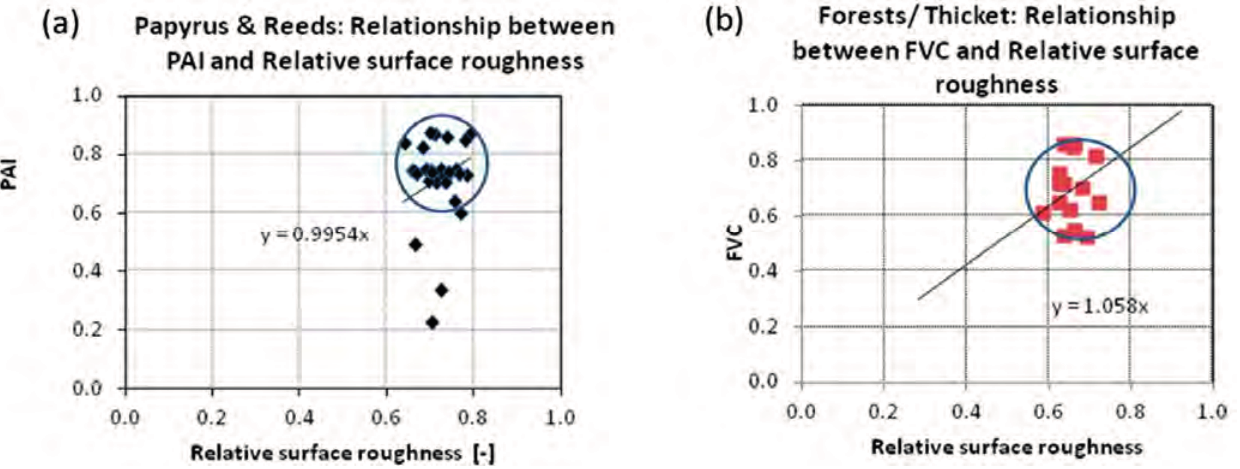
Figure 11. Correlation between Plant Area Index (PAI) and Fractional Vegetation Cover (FVC) against relative surface roughness. The correlation coefficient for plots ( a ), ( b ), are 0.03, 0.08,